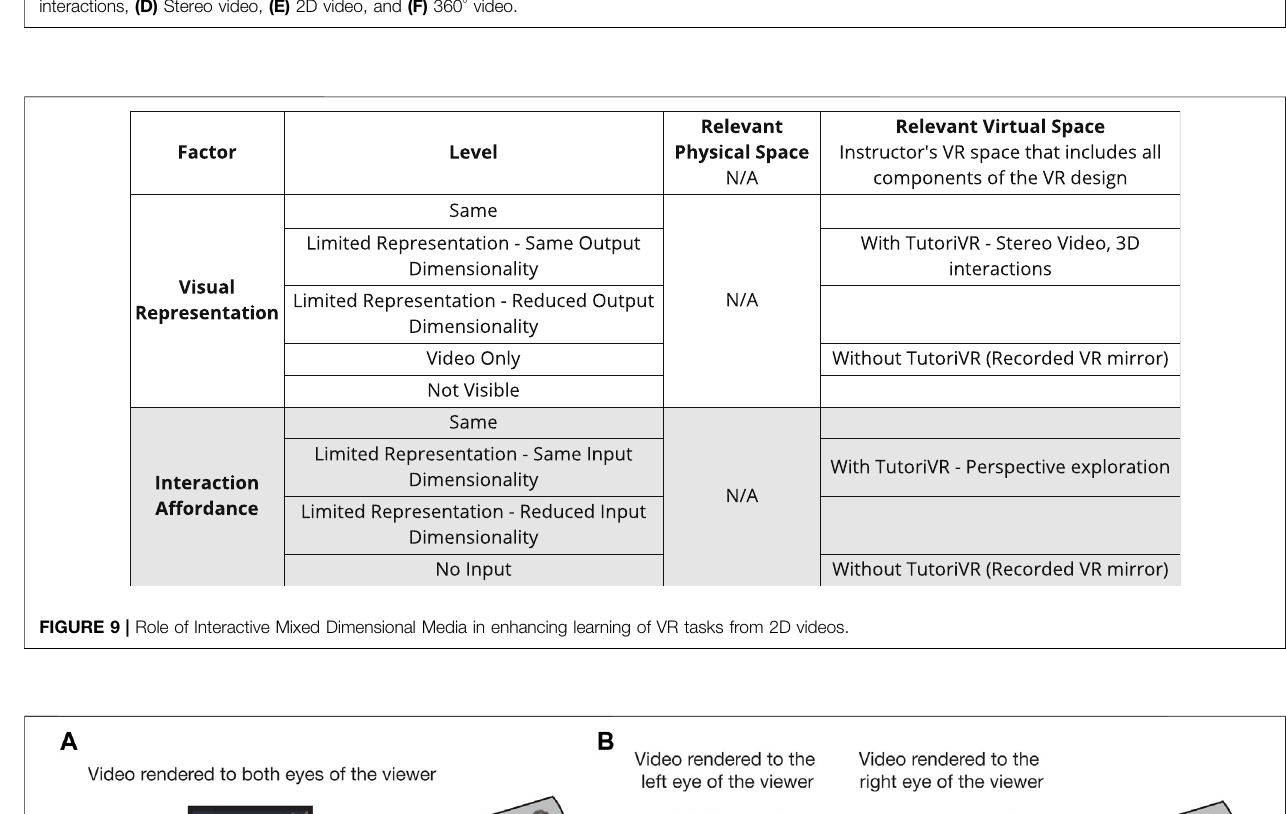
FIGURE 8 | Examples of a few possible visual representations of xspaces that are used in prior work. (A) Original, (B) 3D point cloud, (C) Reconstructed 3D interactions, (D) Stereo video, (E) 2D video, and (F) 360 ° video.